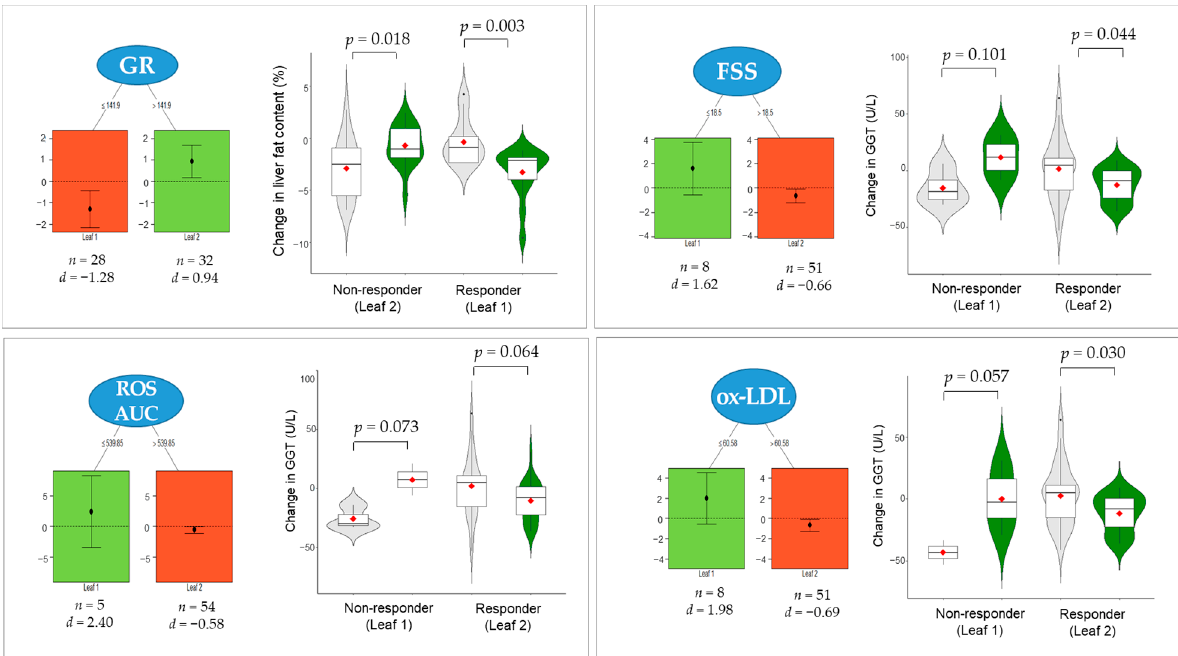
Figure 5. Pruned trees and descriptive statistics of QUINT. The changes ( ∆ 0–12 weeks) in liver fat content with moderator variable “GR” and a split point of 141.9 nmol/min/mL (top left). The changes ( ∆ 0–12 weeks) in GGT level with moderator variables of “FSS” (a split point of 18.5; top right), “ROS AUC “(a split point of 539.85; bottom left), and “ox-LDL” (a split point of 60.58 μ g/mL; bottom right). The corresponding effect sizes d are expressed as the standardized mean difference between the group. BSE is more effective for the red leaves than the placebo; the reverse is valid for the green leaves. The p -values were assessed using a mixed-model repeated-measures analysis for the treatment × visit interaction terms. Violin plots compare the distribution of the changes in liver fat content and GGT level ( placebo; BSE). The interquartile range and median are shown by the vertical bar and black dash, respectively, and the mean is shown by the red dot. GR, glutathione reductase; FSS, fatigue severity scale; ROS, reactive oxygen species; AUC, area under the curve; ox-LDL, oxidized low-density lipoprotein; GGT, γ -glutamyl transferase; BSE, barley sprout extract powder.